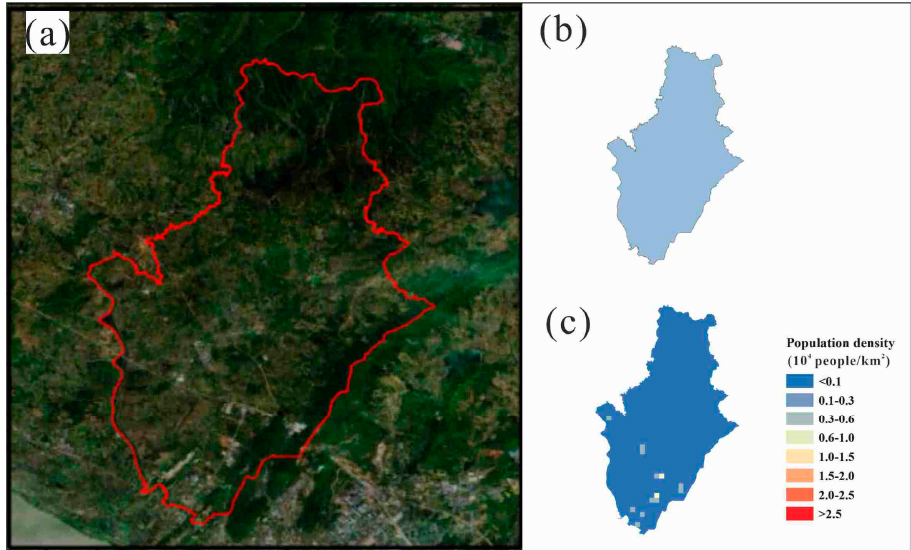
Figure 10. Comparison of ( a ) the high-resolution image, ( b ) the population density at the township scale, and ( c ) that at the 500 m scale in Xiage Township as the low-density areas.